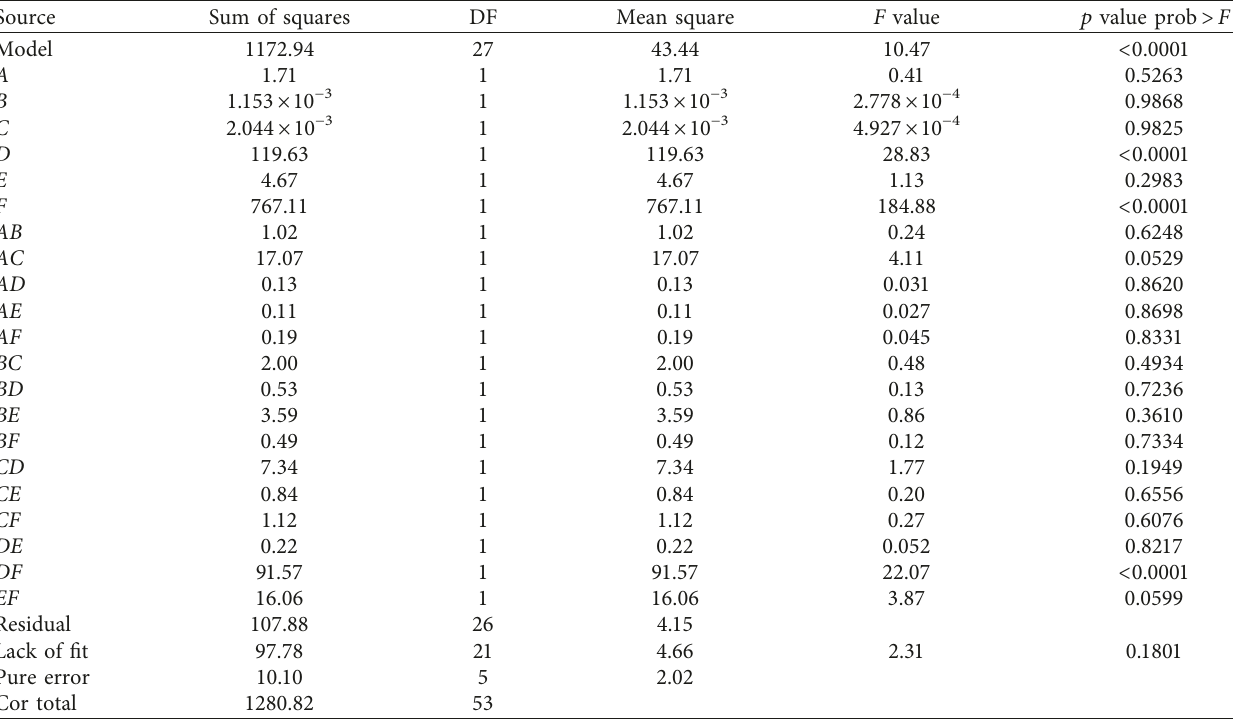
Table 4: Analysis of variance of surface roughness.